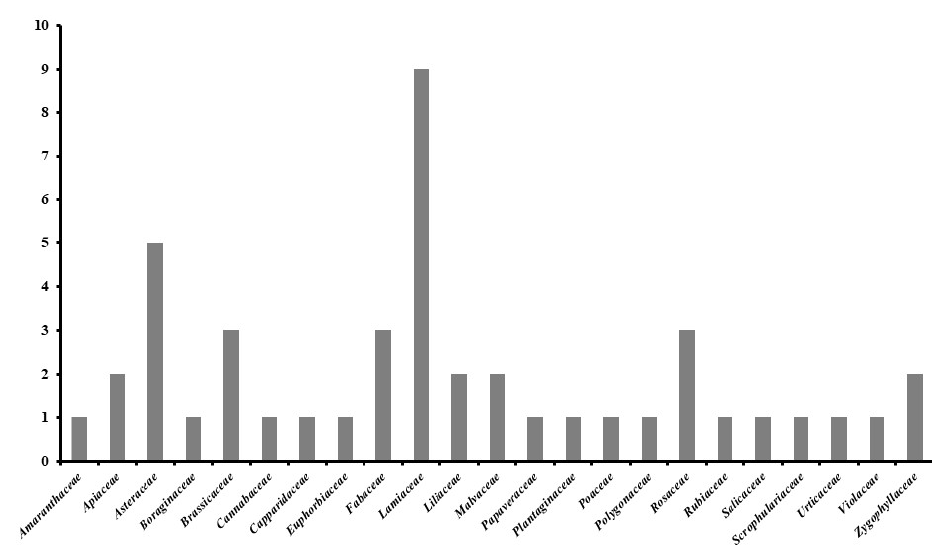
Figure 3. Number of species per family with medicinal importance found in the study